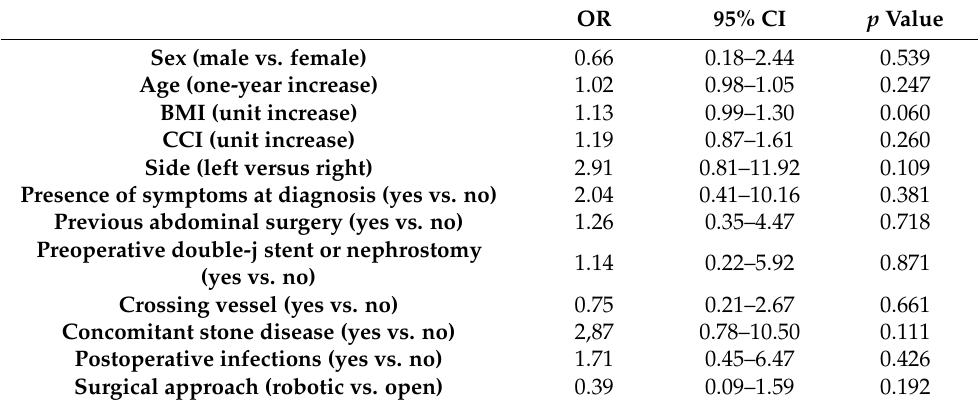
Table 4. Univariate logistic regression analysis evaluating factors associated with